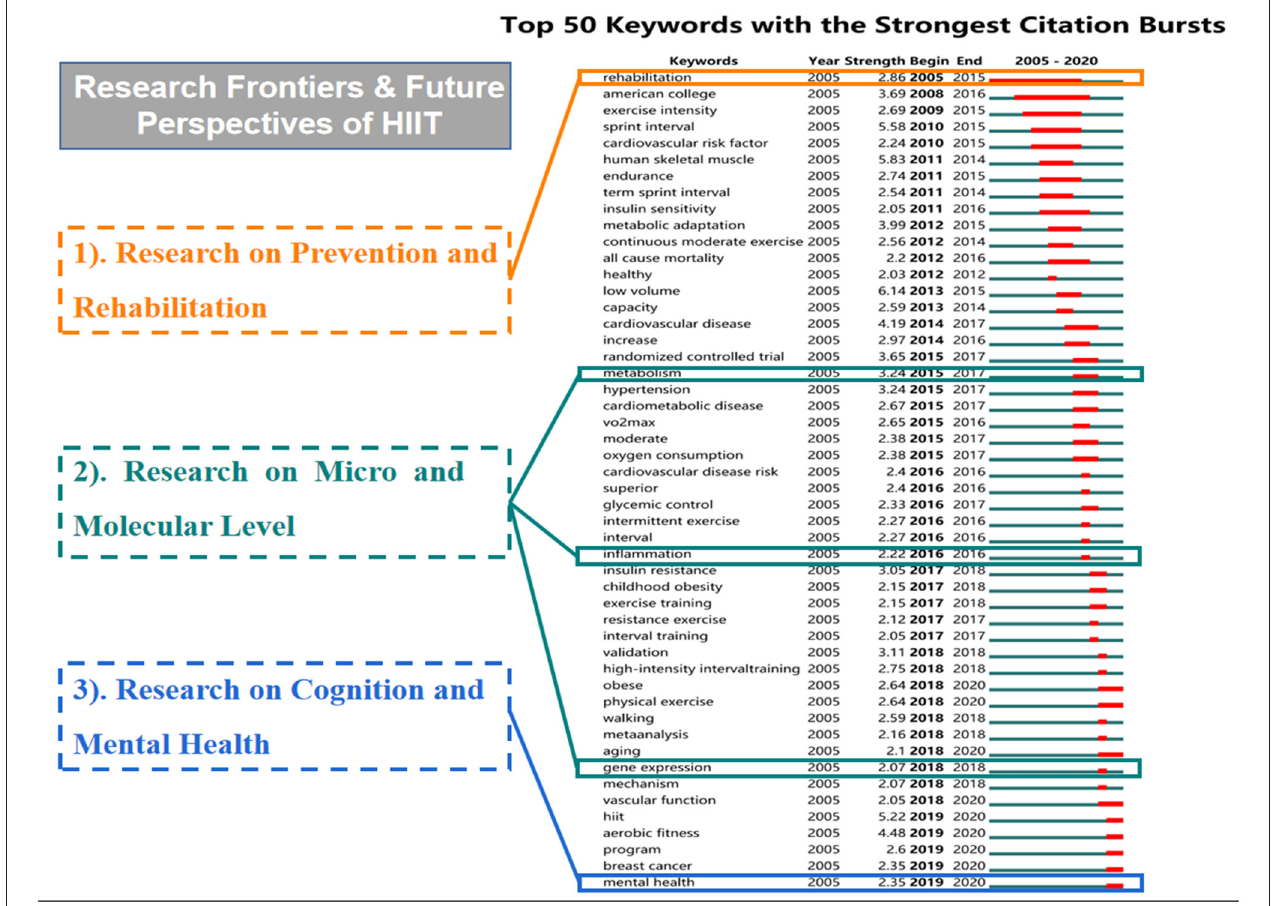
FIGURE 8 | Top 50 keywords with the strongest citation burst in the HIIT-HP